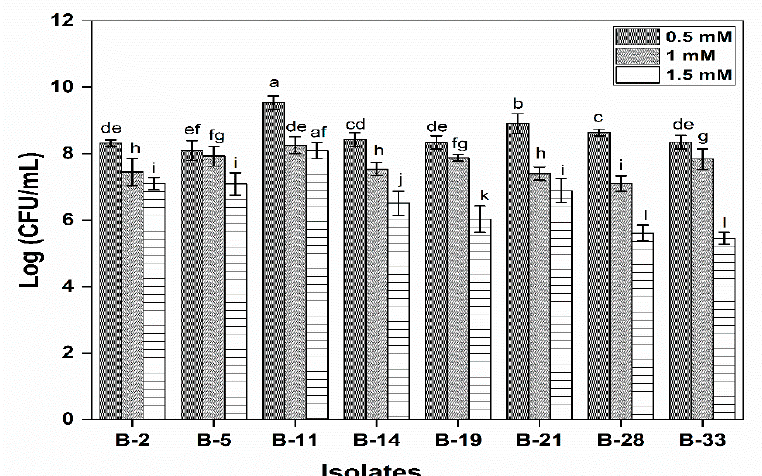
Figure 3. Resistance to hydrogen peroxide is determined by calculating the bacterial count of isolates at different concentration of hydrogen peroxide i.e., 0.5 mM, 1 mM and 1.5 mM. Each value represents the mean value ± standard deviation (SD) ( n = 3). Bars with different lower-case letters denoted significantly different ( p < 0.05).